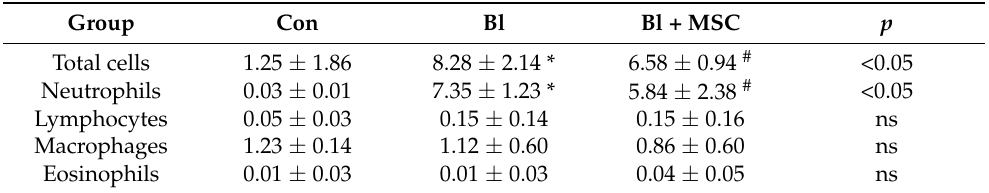
Table 2. Total and differential cell counts in BALF